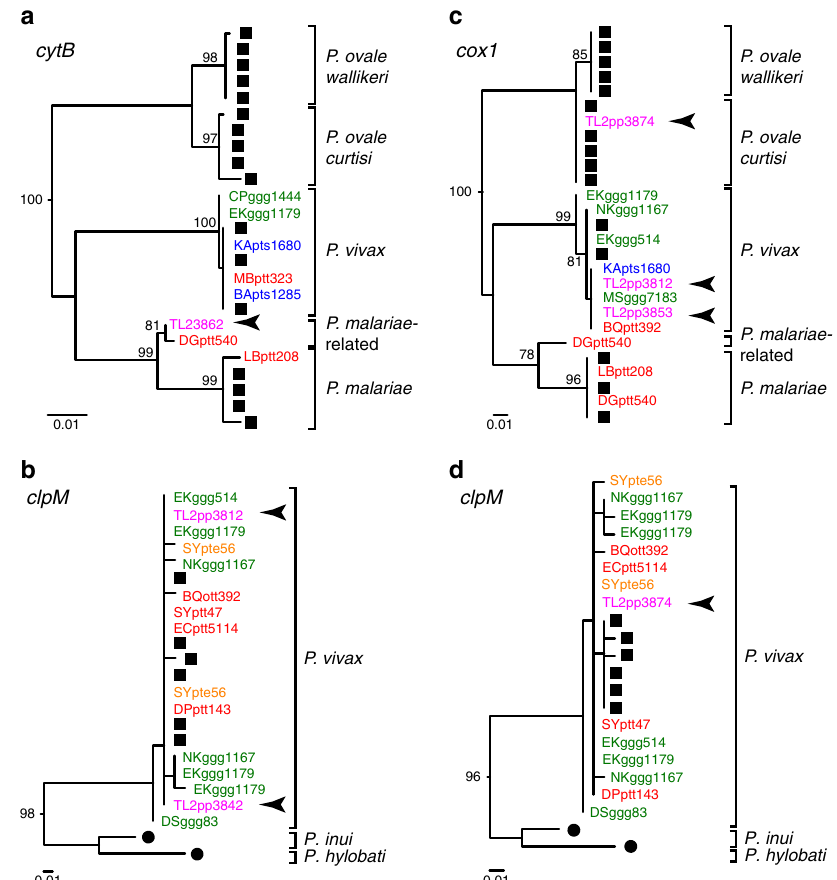
Fig. 4 Bonobo infections with non- Laverania parasites. Maximum likelihood phylogenetic trees are shown for mitochondrial and apicoplast gene sequences of non- Laverania parasites. Ape-derived a cytB (956 bp), b clpM (327 bp), c cox1 (296 bp) and d clpM (574 bp) sequences are labelled and coloured as in Fig. 2 (identical sequences from different samples are shown; identical sequences from the same sample are excluded). Human and monkey parasite reference sequences from the database are labelled by black squares and circles, respectively. Brackets indicate non- Laverania species, including P. malariae, P. vivax, P. ovale curtisi and P. ovale wallikeri (available sequences are too short to differentiate ape- and human-speci fi c lineages) as well as the monkey parasites P. inui and P. hylobati . Newly identi fi ed bonobo parasite sequences are indicated by arrows, all of which are from the TL2 site. One TL2 cytB sequence clusters with a previously reported parasite sequence from a chimpanzee sample (DGptt540), forming a well-supported lineage that is only distantly related to human and ape P. malariae , and thus likely represents a new P. malariae -related species. The trees were constructed using PhyML 58 with GTR+G ( a ), TRN+I ( b , d ) and TIM2+I ( c ) as evolutionary models. Bootstrap values over 70% are shown for major nodes only (the scale bar